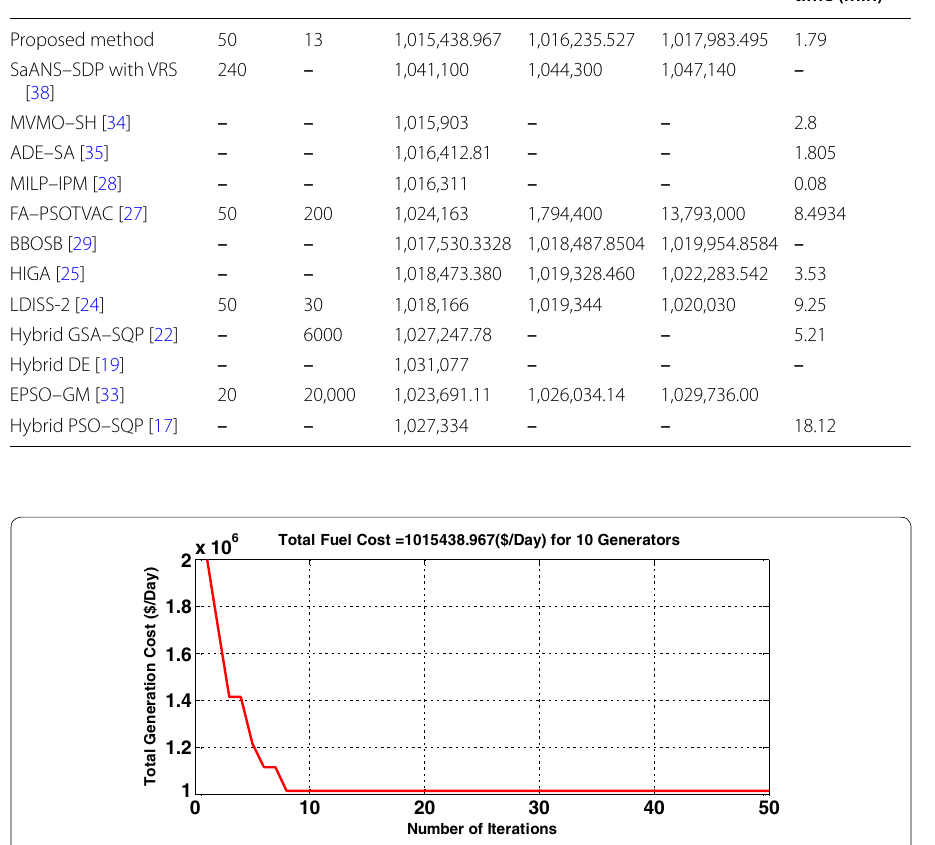
Table 13 Cost and computation time comparison of optimization results in case 3 Method